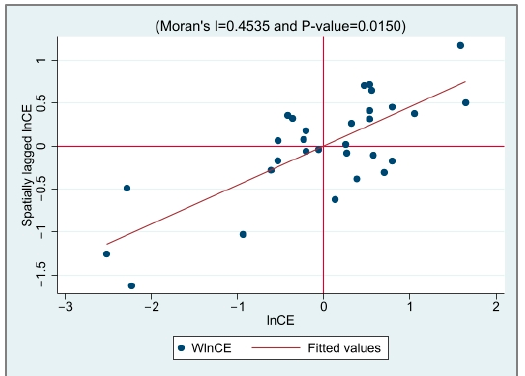
Figure 4. The scatter plot of the Moran index of CED in 2019.